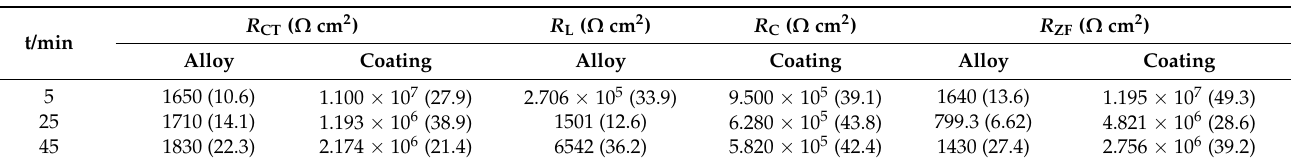
Figure 6. Equivalent electrical circuit proposed to fit the EIS responses of the corrosion systems. ( a ) For alloy and ( b ) for MAO coating. Table 2. The fitting results of resistances in the EEC for AZ91 alloys before and after MAO treatment after different immersion times.